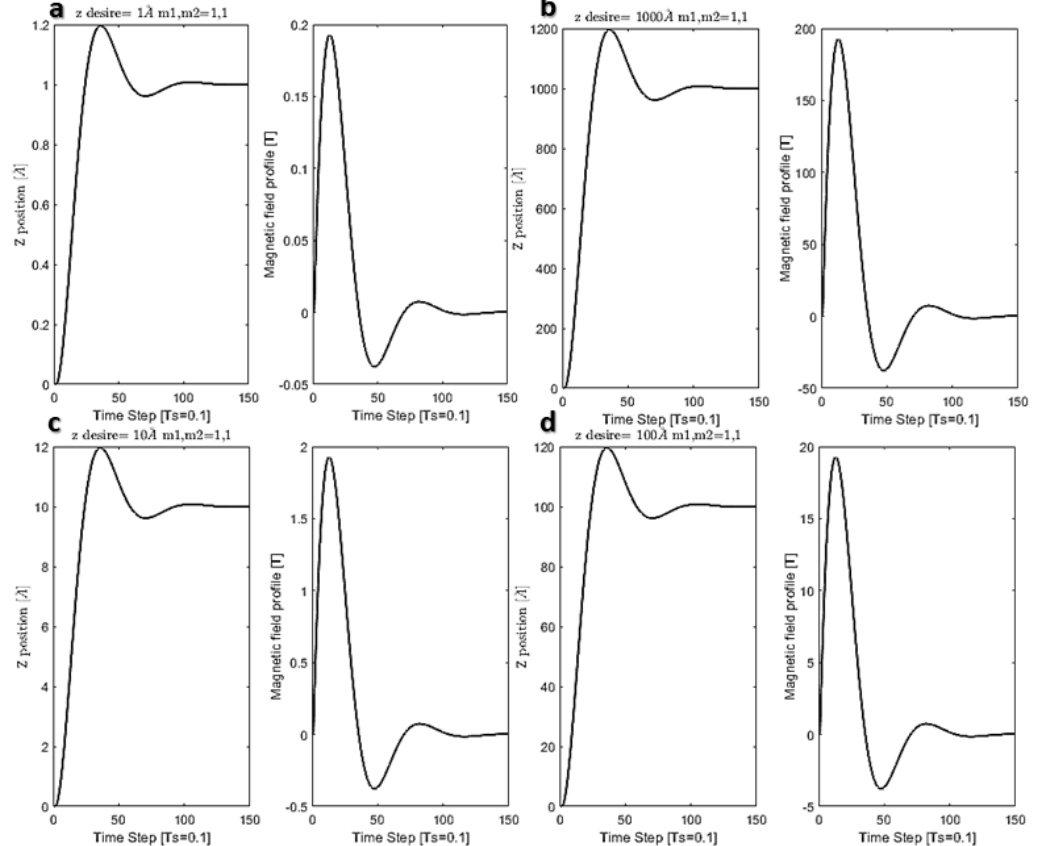
Figure 12. Position control of functionalized CNT inside the cell ( a ) z-position of the particle inside the cell for translocating around 1 Å and the maximum magnetic field of 200 mT. ( b ) z-position of the particle inside the cell for translocating around 1000 Å and the maximum magnetic field of 180 T. ( c ) z-position of the particle inside the cell for translocating around 10 Å and the maximum magnetic field of 180 mT. ( d ) z-position of the particle inside the cell for translocating around 100 Å and the maximum magnetic field of 18 T.